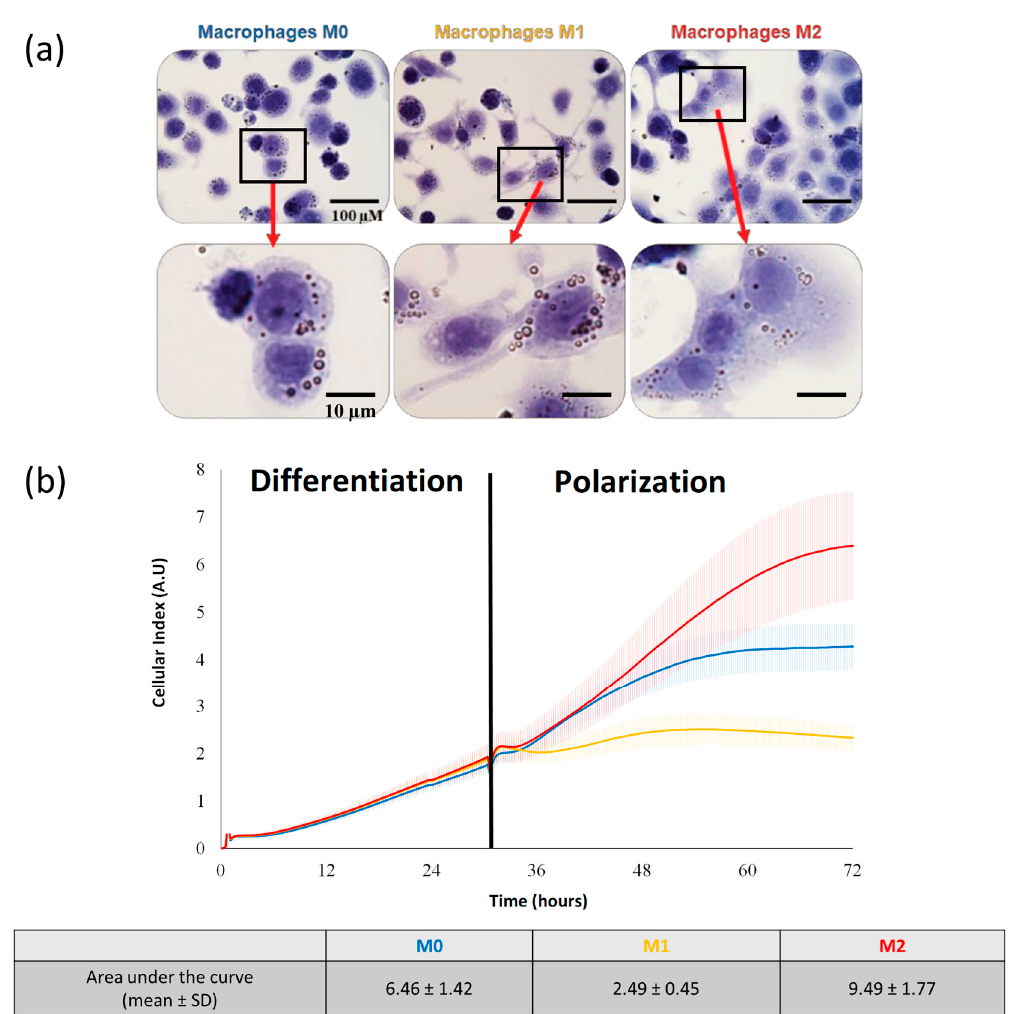
Figure 2. Morphological appearance and adhesion capacity of macrophages. ( a ) Morphological changes by optical image microscopy were assessed seven days after the polarization process. ( b ) Adhesion capacities by impedance measurements. The mean values of the cell index are represented by a solid line, integrating the variability of the measurements (6 replicates/group). The area under the curve values (mean ± SD) were calculated between 24 h and 72 h during the polarization phase.